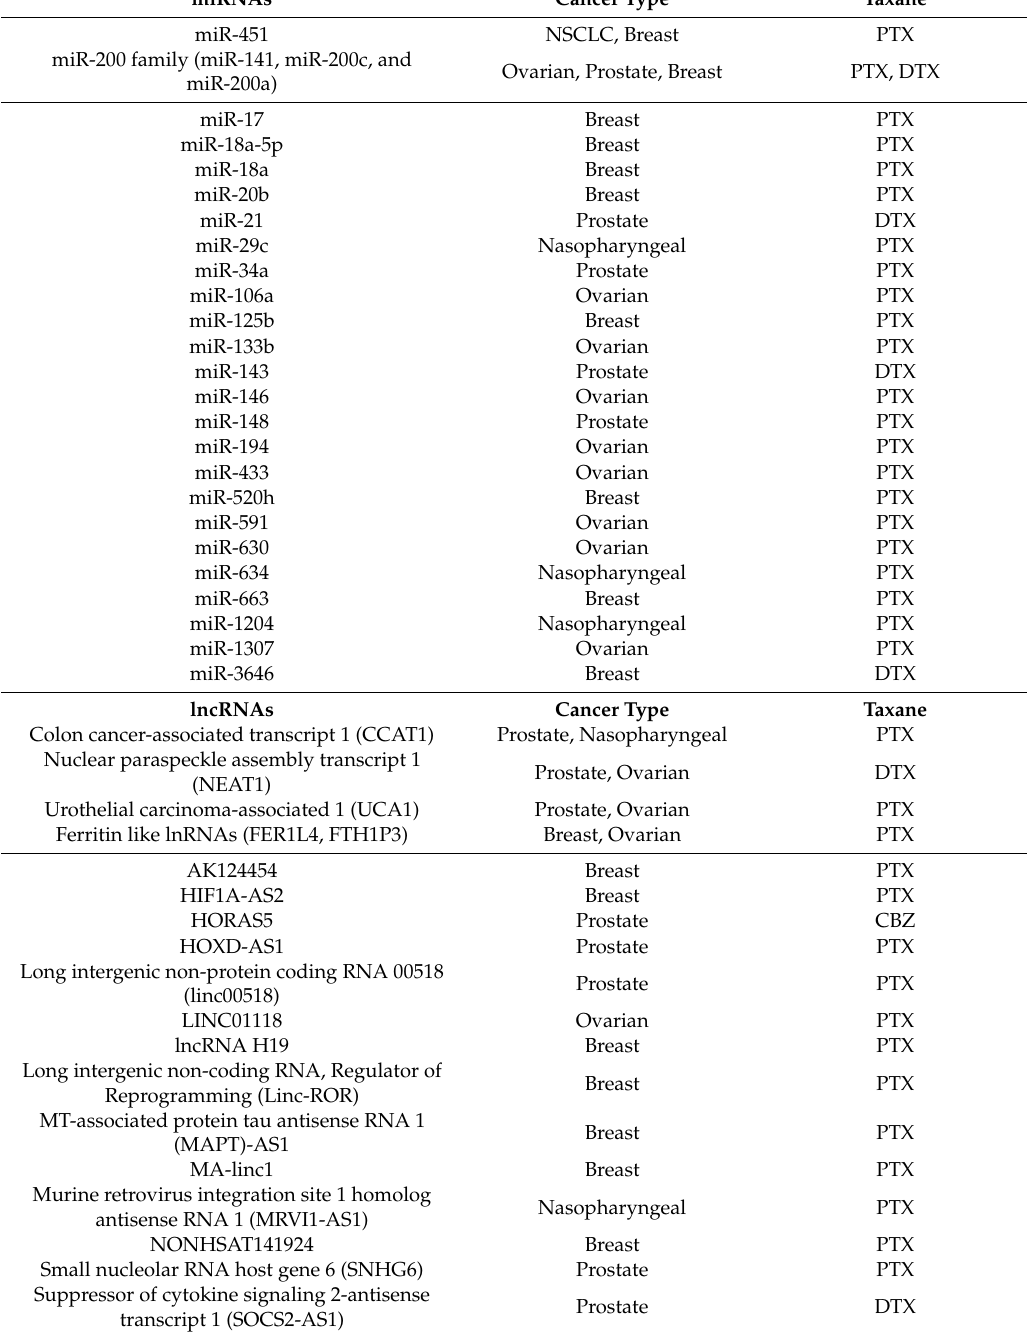
Table 3. Non-coding RNAs involved in chemoresistance. The common miRNAs and lncRNAs are listed first. See text for